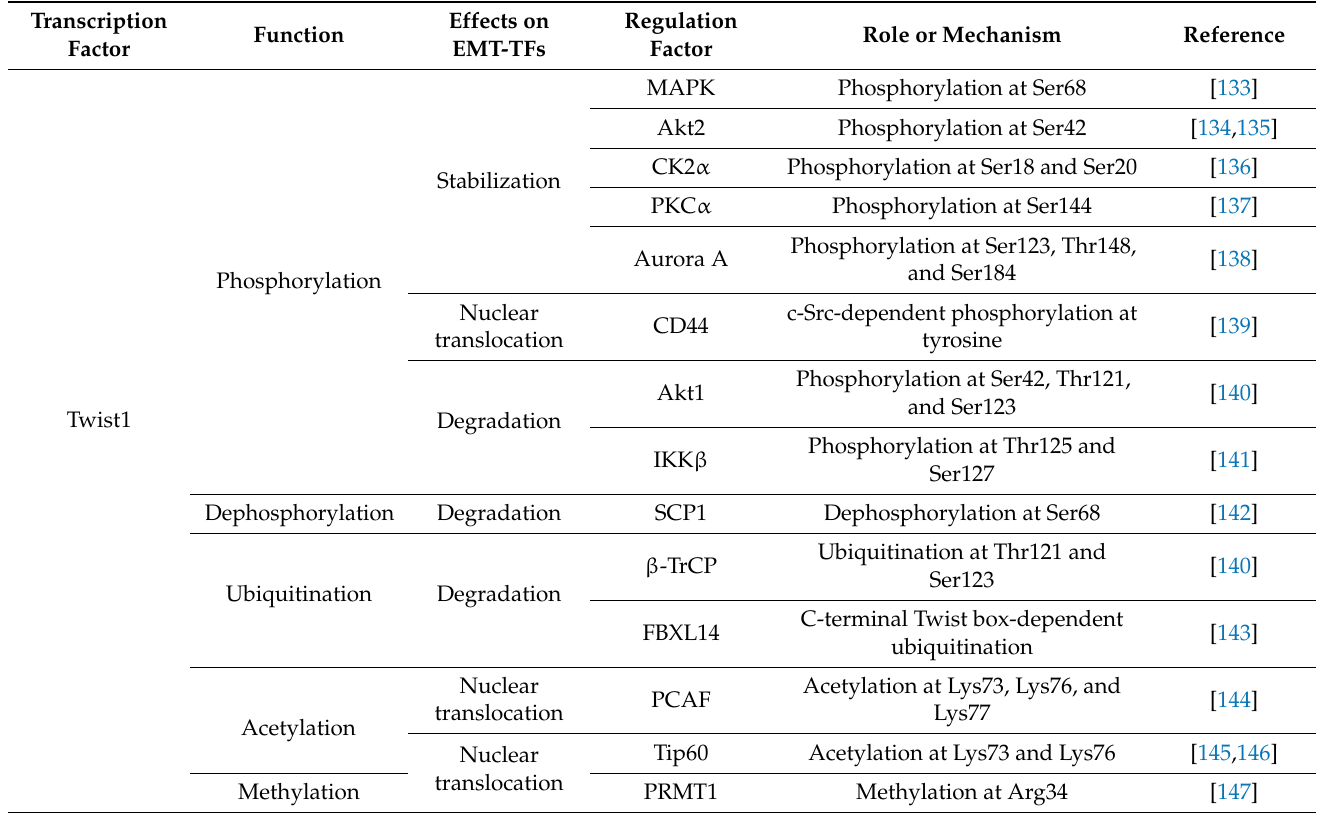
Table 2. Regulation of the Twist family by